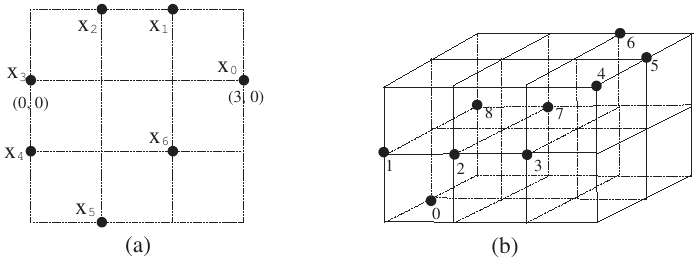
Figure 1. ( a ) One specific example of a member of the set of closed curves, C 2,7 the underlying 2-dimensional lattice is shown as a dashed grid. The closed curve consisting of 7 points appears black dots labeled x 1 through x 6 . ( b )One specific example of a member of the set of closed curves, C 3,9 . Now n = 3, so the lattice is 3-dimensional (dashed grid). The closed curve of 9 18 points runs from 0 through